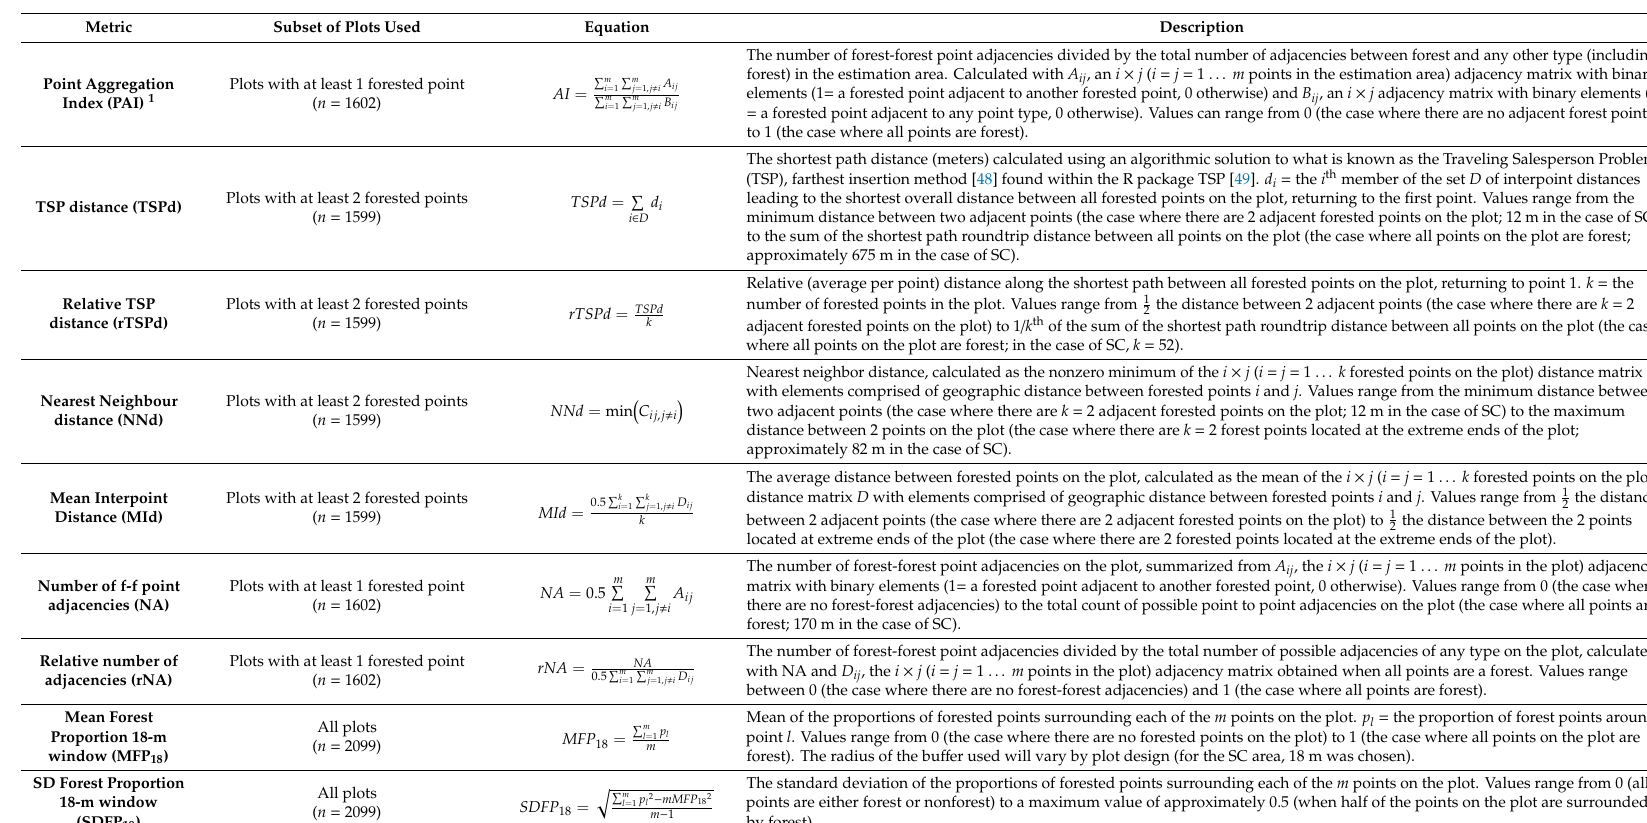
Table 1. Landscape metrics calculated at the plot-level for the forest fragmentation and degradation analysis conducted in the Schuylkill County (SC) study area. For Maryland (MD) and Prince George’s County (PG), only PAI (Point Aggregation Index) was calculated, summarized at the landscape-level. The subset of plots used represents the subset of the total number of plots in the population for which calculation of the metric is feasible. Infeasible calculations can consist of scenarios leading to division by zero, or, for some metrics, distance calculations between forested points on plots with 1 or fewer forested points. Sample sizes ( n ) used for each metric in the SC study area are